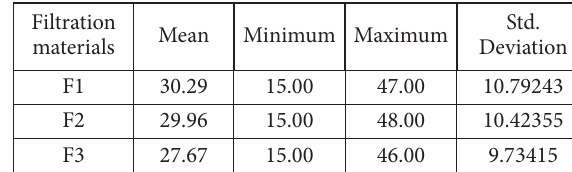
Table 12. Kruskal-Wallis rank test results of the leaf number values in the experiments with different filtration materials Filtration materials